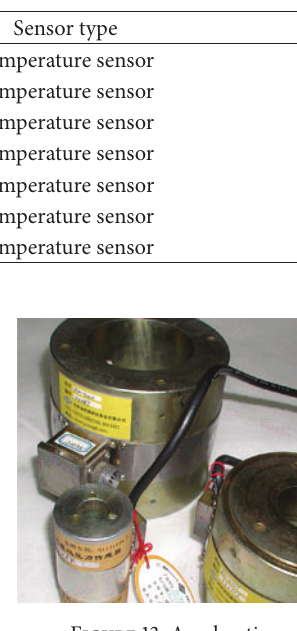
Table 8: Position and number of temperature monitoring points.